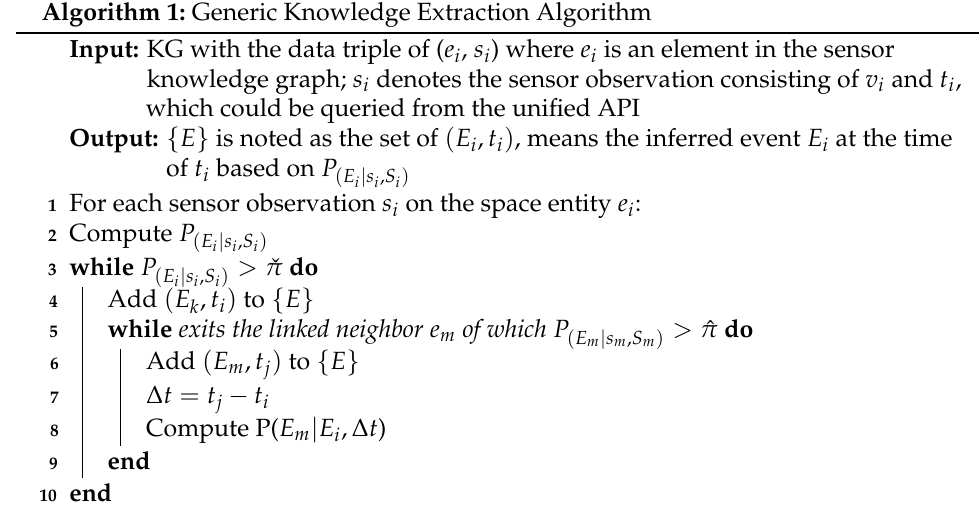
Algorithm 1: Generic Knowledge Extraction